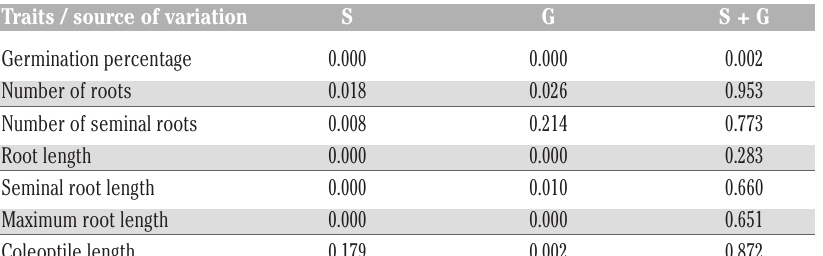
Table 5. Summary of the P values of two-way ANOVAs for the effects of salinity (S), geno- type (G), and their interaction (S + G) on the germination and root architectural traits of durum wheat landraces.